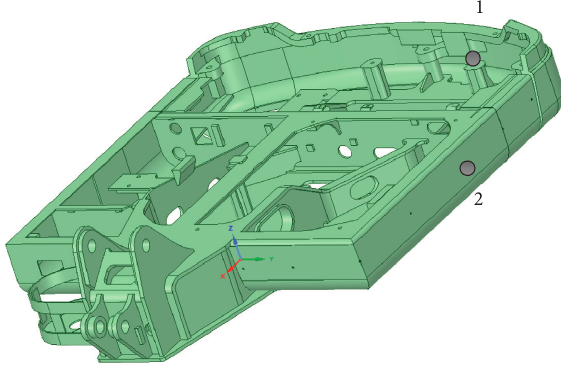
Figure 5: Measuring point positions on the rotary